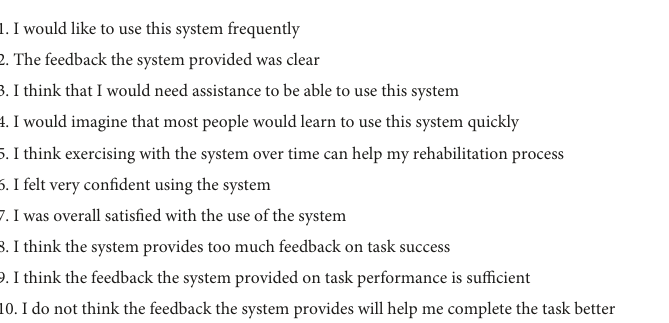
TABLE 1 Questions presented at the end of the control condition (CT) [based on the system usability scale (SUS)